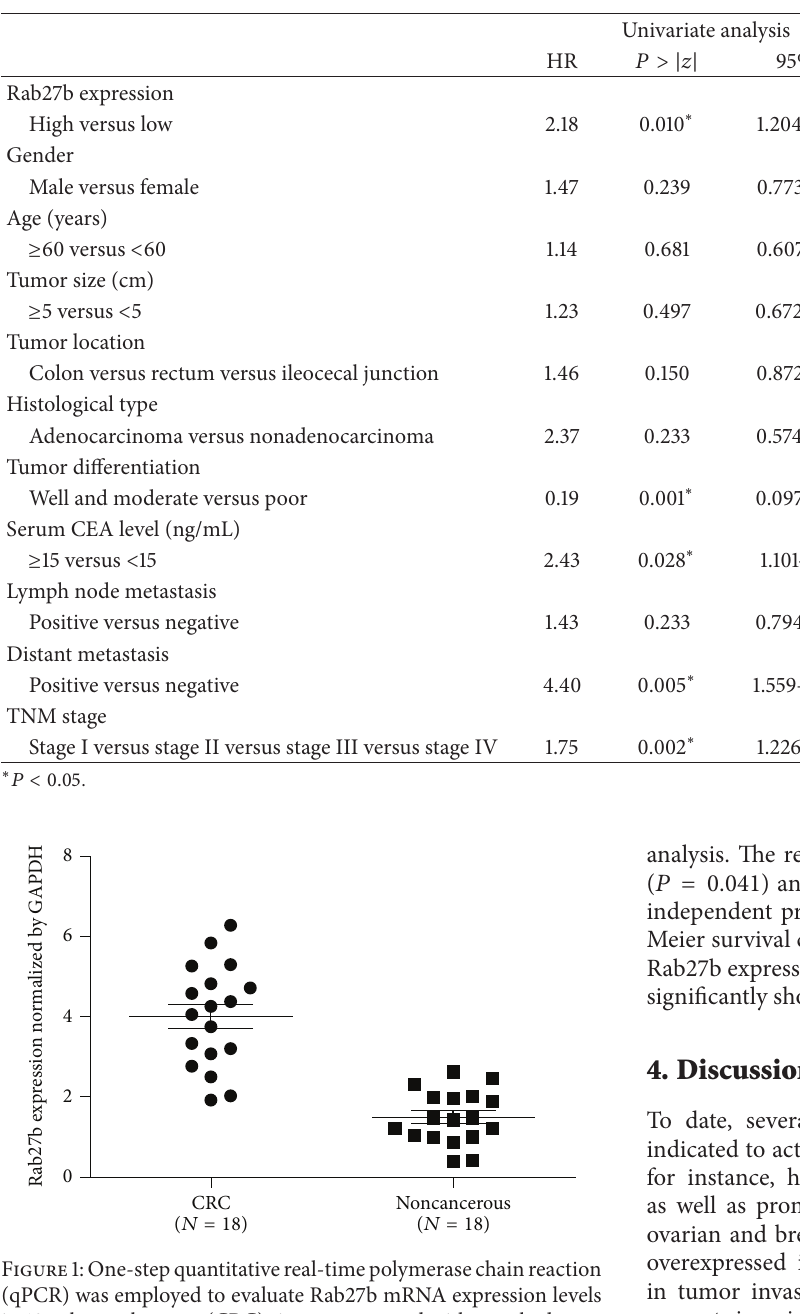
Table 2: Univariate and multivariate analysis of prognostic factors in 113 CRC patients for overall survival.